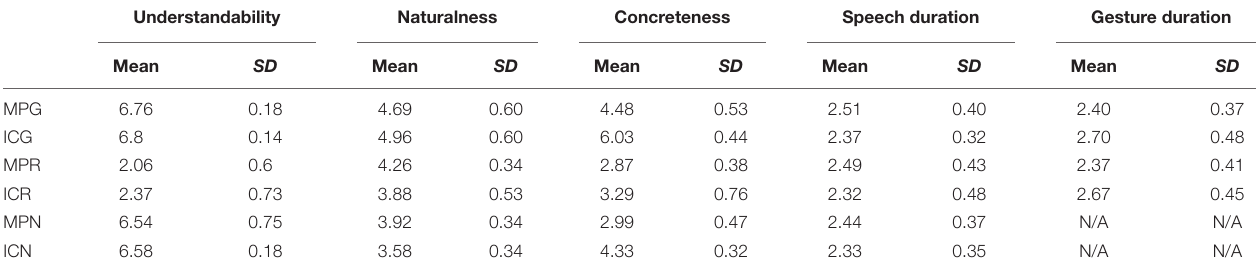
Understandability Naturalness Concreteness Speech duration Gesture